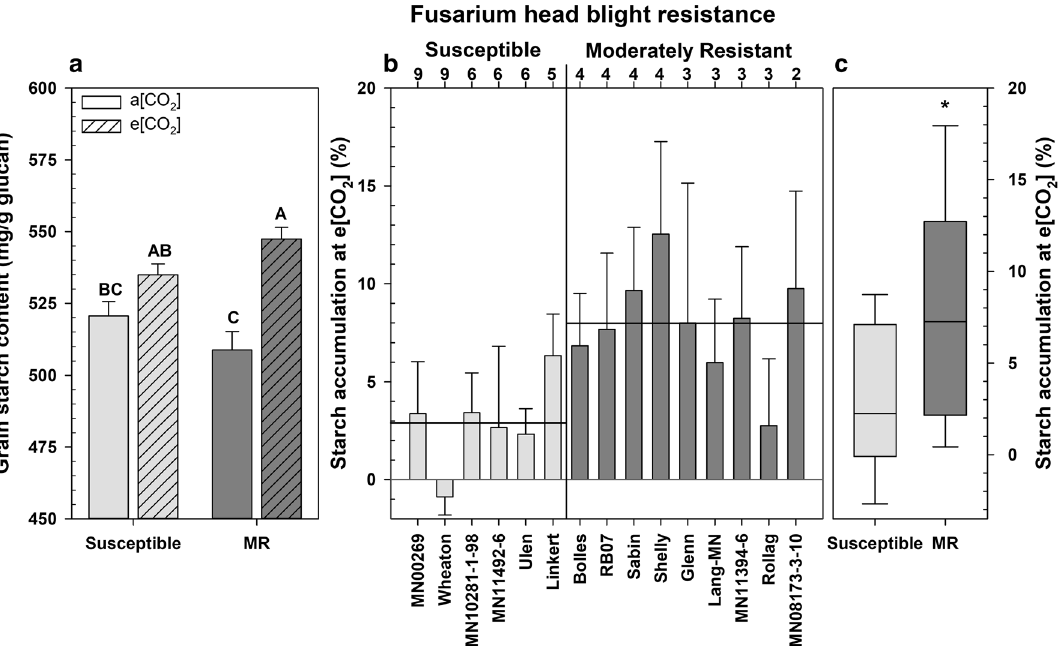
Figure 4. Percent grain starch accumulation of various Fusarium head blight (FHB) moderately resistant (MR) and susceptible wheat cultivars. Starch accumulation determined by evaluating differences in starch content from wheat grown at elevated CO 2 . ( a ) Grain starch content of susceptible and MR wheat grain grown at ambient (a[CO 2 ]) and elevated (e[CO 2 ]), error bars represent standard error. ( b ) Percent starch accumulation at e[CO 2 ] by cultivar and FHB resistance score. Horizonal bars represent group mean starch accumulation, error bars represent standard error. Wheat cultivars were ordered by FHB resistance score at the top of the figure panel. ( c ) Percent starch accumulation by FHB group. Different letters or asterisks (*) denote statistically significant differences as determined by a Tukey adjusted generalized mixed model analysis of variance ( P < 0.05); MR ( n = 27), and susceptible ( n = 18), for each CO 2 growth condition.